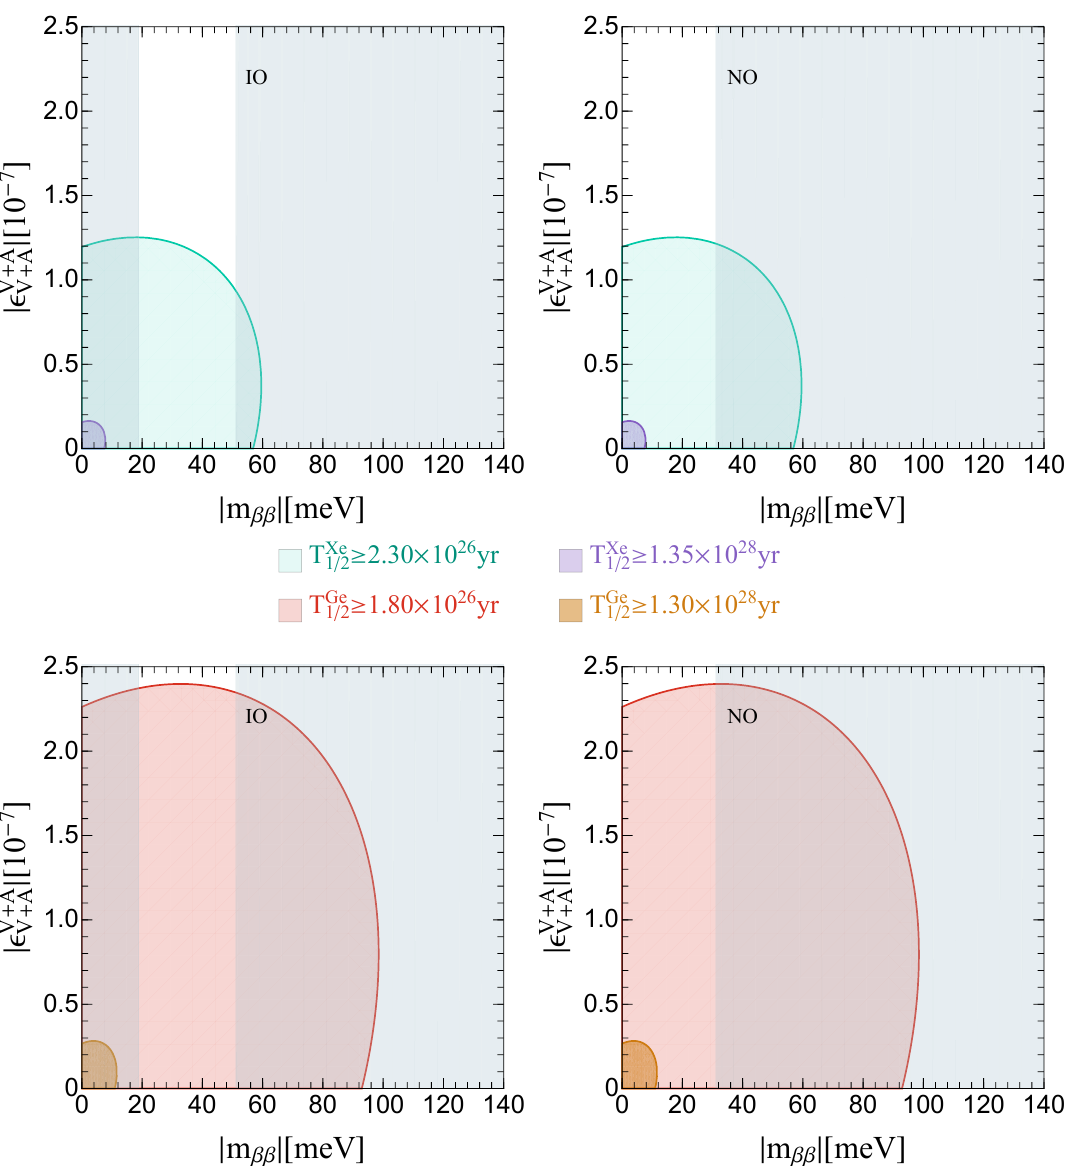
Figure 17 . Constraints on the effective neutrino mass | m the top panels, the highlighted regions represent the parameter space allowed by the current bounds T ( 136 Xe ) > 2 . 3 × 10 26 yr [1] and the future sensitivities T 1 / 2 the bottom panels display the parameter space allowed by the current bounds T yr [50] and the future sensitivities T